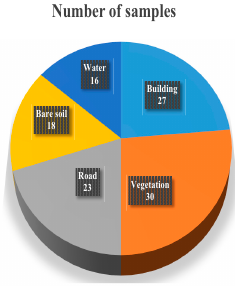
Figure 3. Proportion of the samples data gathered from the reviewed studies for each land cover class.